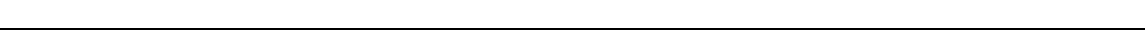
Fig. 2 NT-3 generated long-range Ca 2+ signaling from the axon to the cell body. a Long-range Ca 2+ wave. The relative change in the Cal-520 emission